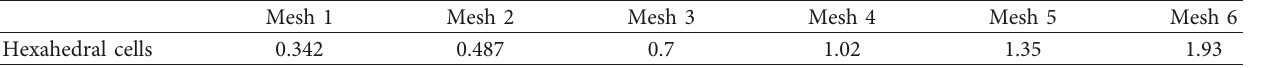
Figure 3: 3D section of meshed open channel geometry. The rectangular channel height, width, and length are, respectively, 0.2m, 0.3m, and 1m. Table 1: Different mesh for mesh independency check.